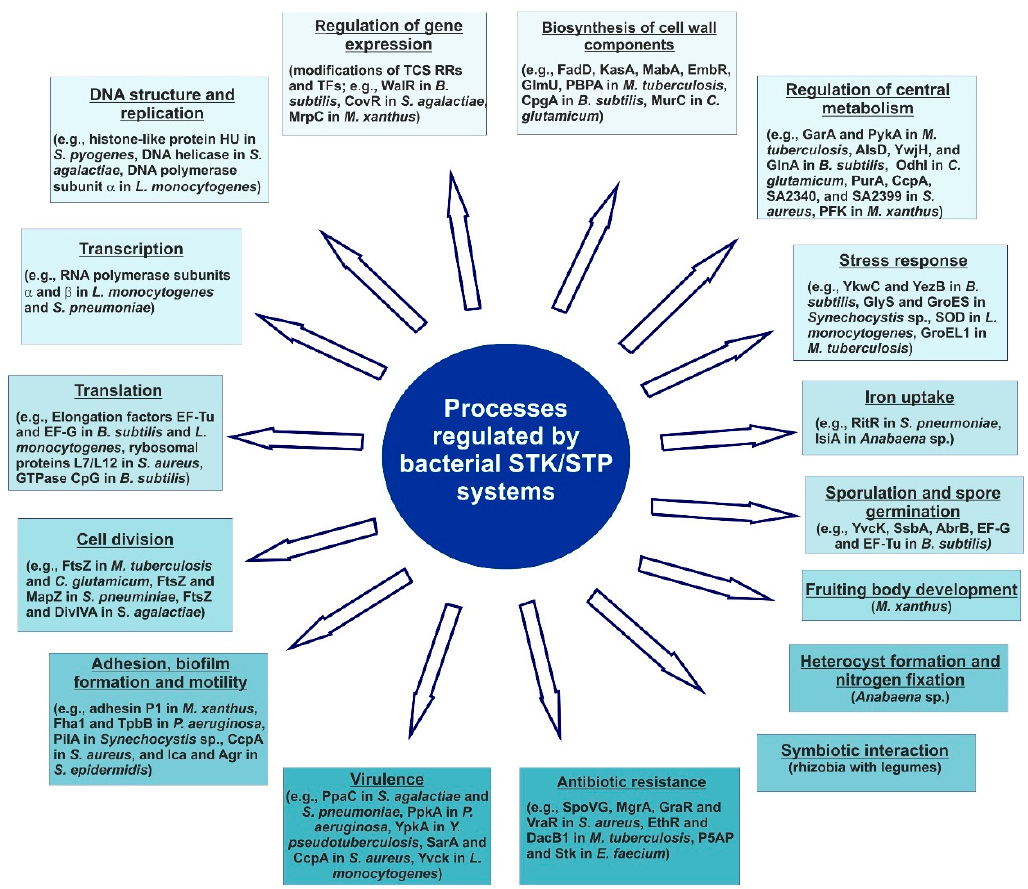
Figure 3. A scheme showing physiological processes regulated by bacterial Hanks-type STKs and STPs in different bacteria.